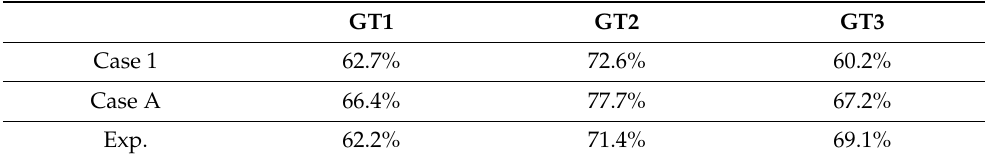
Table 4. This table displays the SO 2 removal efficiencies of small-scale tower by numerical and experimental results [36] at different sampling points as L / G = 4.9.